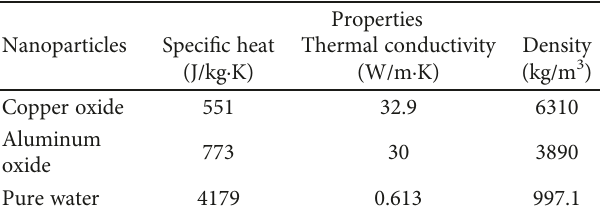
Table 1: Thermophysical properties of nanoparticles. Nanoparticles